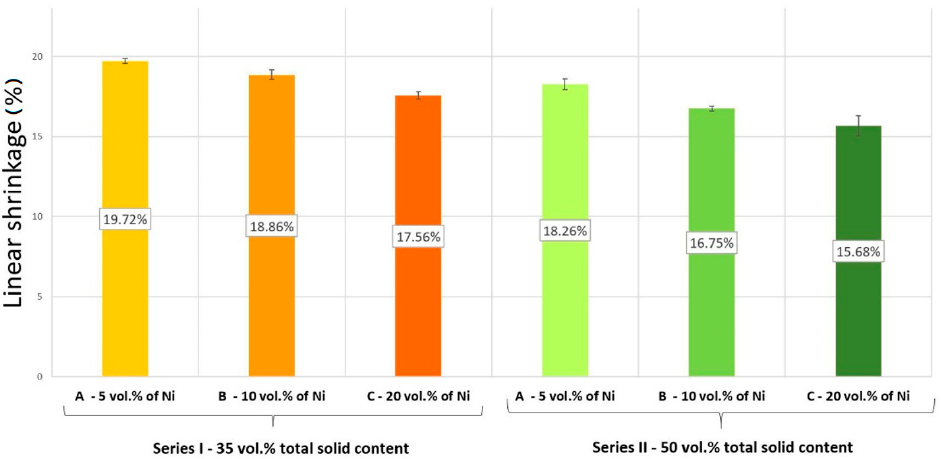
Figure 10. Values of linear shrinkage of the produced composites.